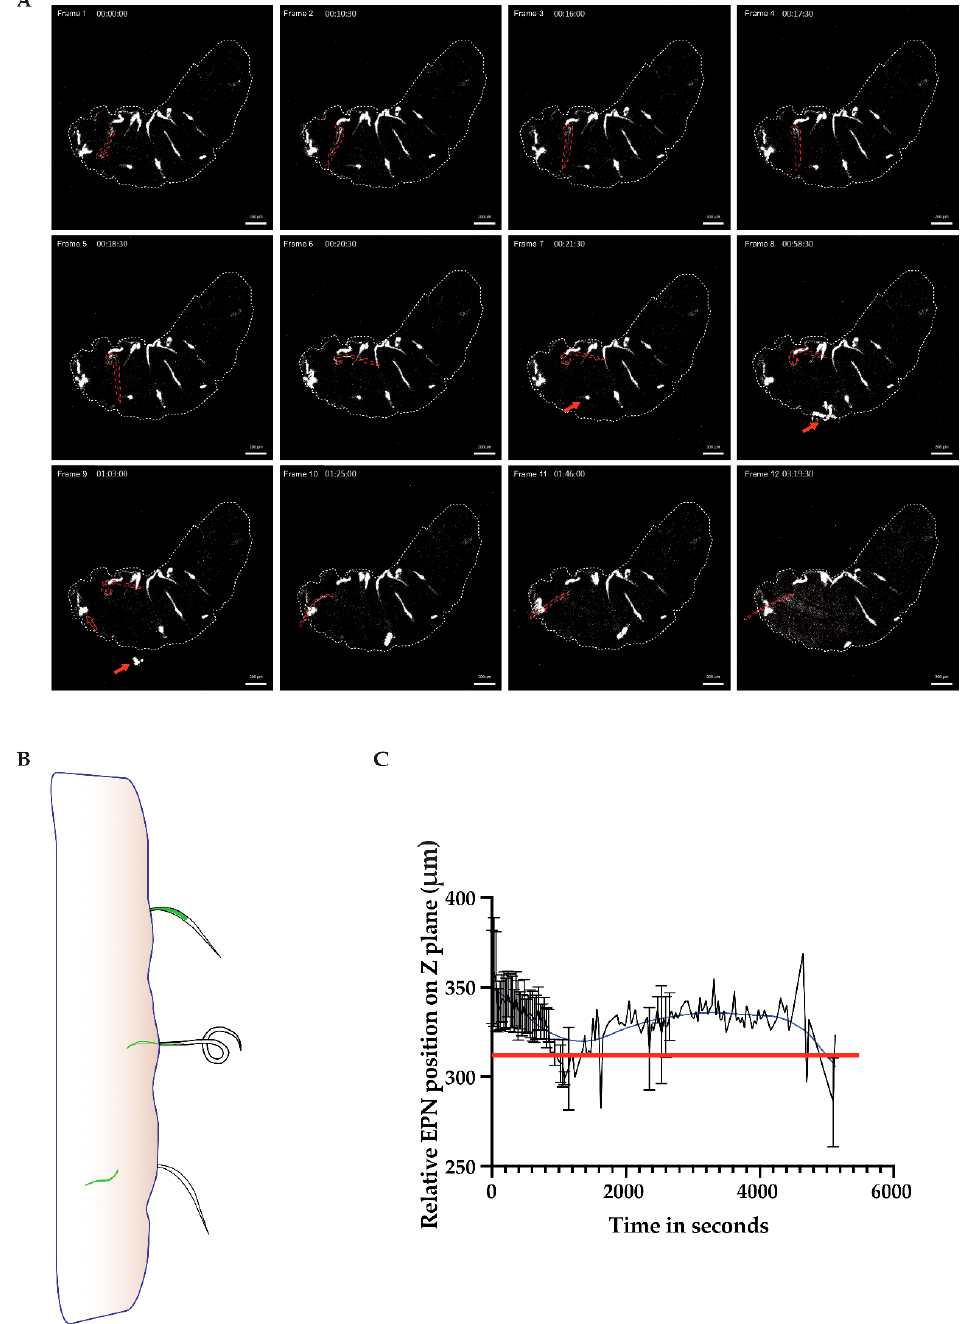
Figure 1. Time-lapse series of Heterorhabditis bacteriophora entering the Drosophila cuticle. L3 w 1118 larvae were infected with 500 IJ/ 10 μ L per larva in a bag assay. After around 45 min, a larva was selected, glued to a 13-mm coverslip, and imaged using a confocal microscope, the LSM 800. Time lapses were taken for 5 to 6 h documenting the early stages of infection in Drosophila . Stills demonstrating key points of interest from a representative larva being infected with an entomopathogenic PN, outlined